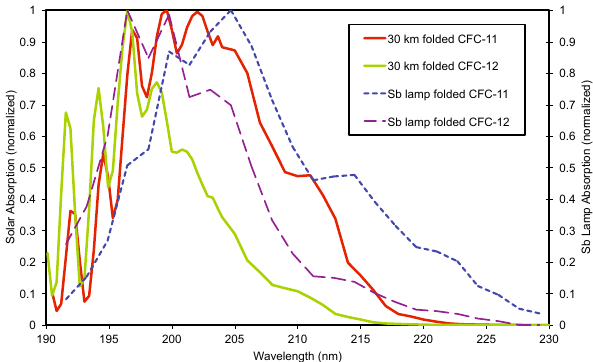
Fig. 3. Product of CFC-11 and -12 absorption spectra and solar and SB lamp spectra, normalized.